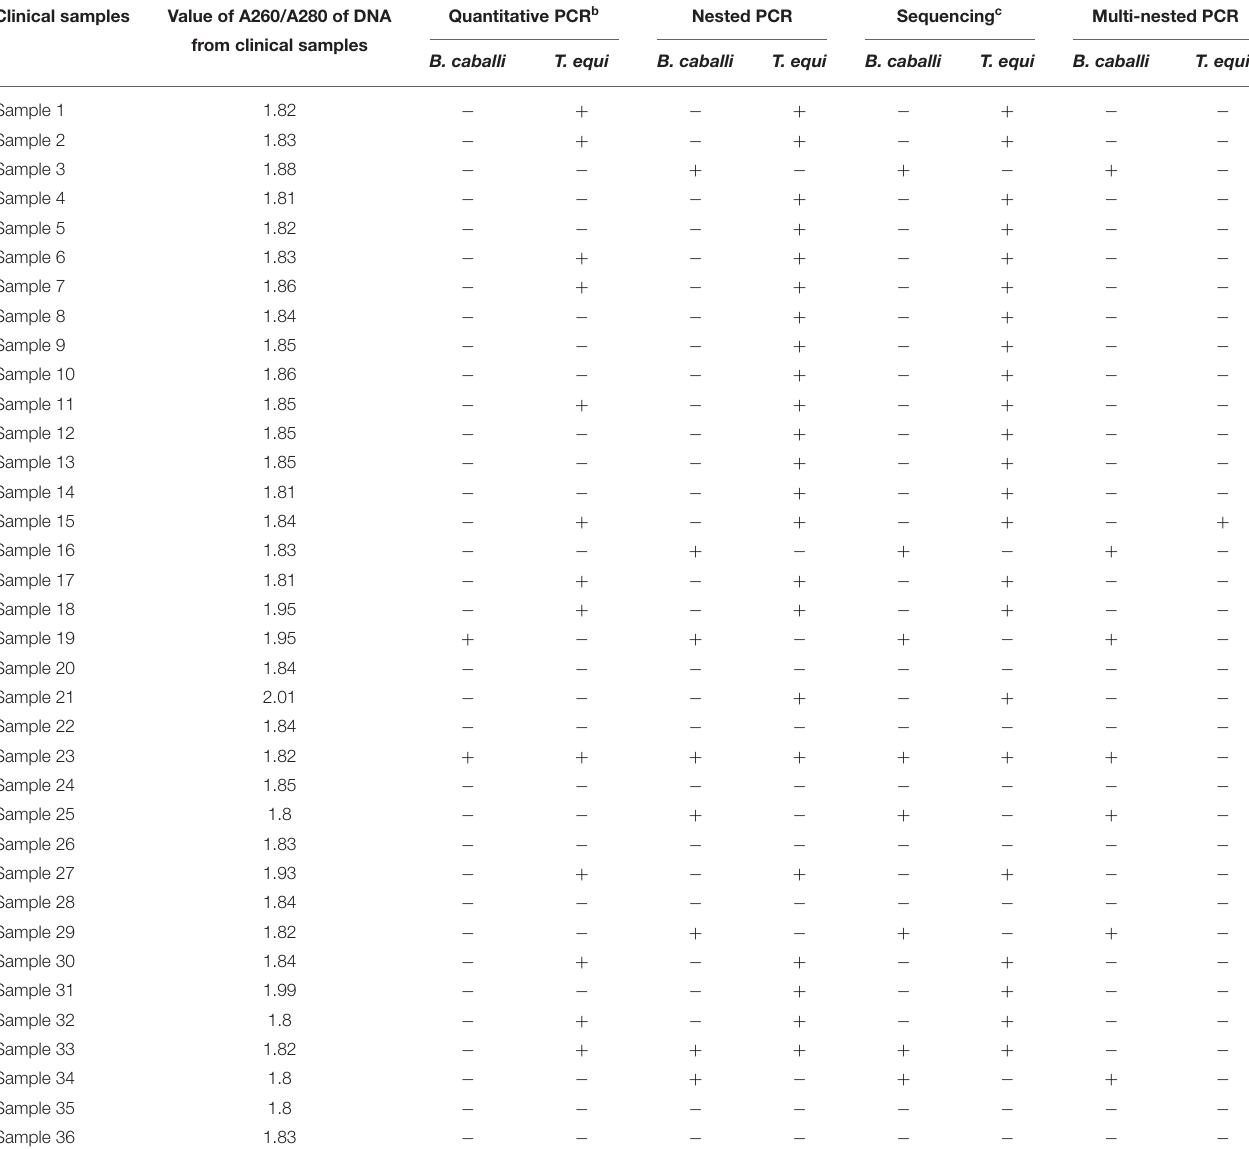
TABLE 4 | Comparison of nested PCR, multi-nested PCR and duplex real-time fluorescence quantitative PCR for detecting equine piroplasmosis a . Clinical